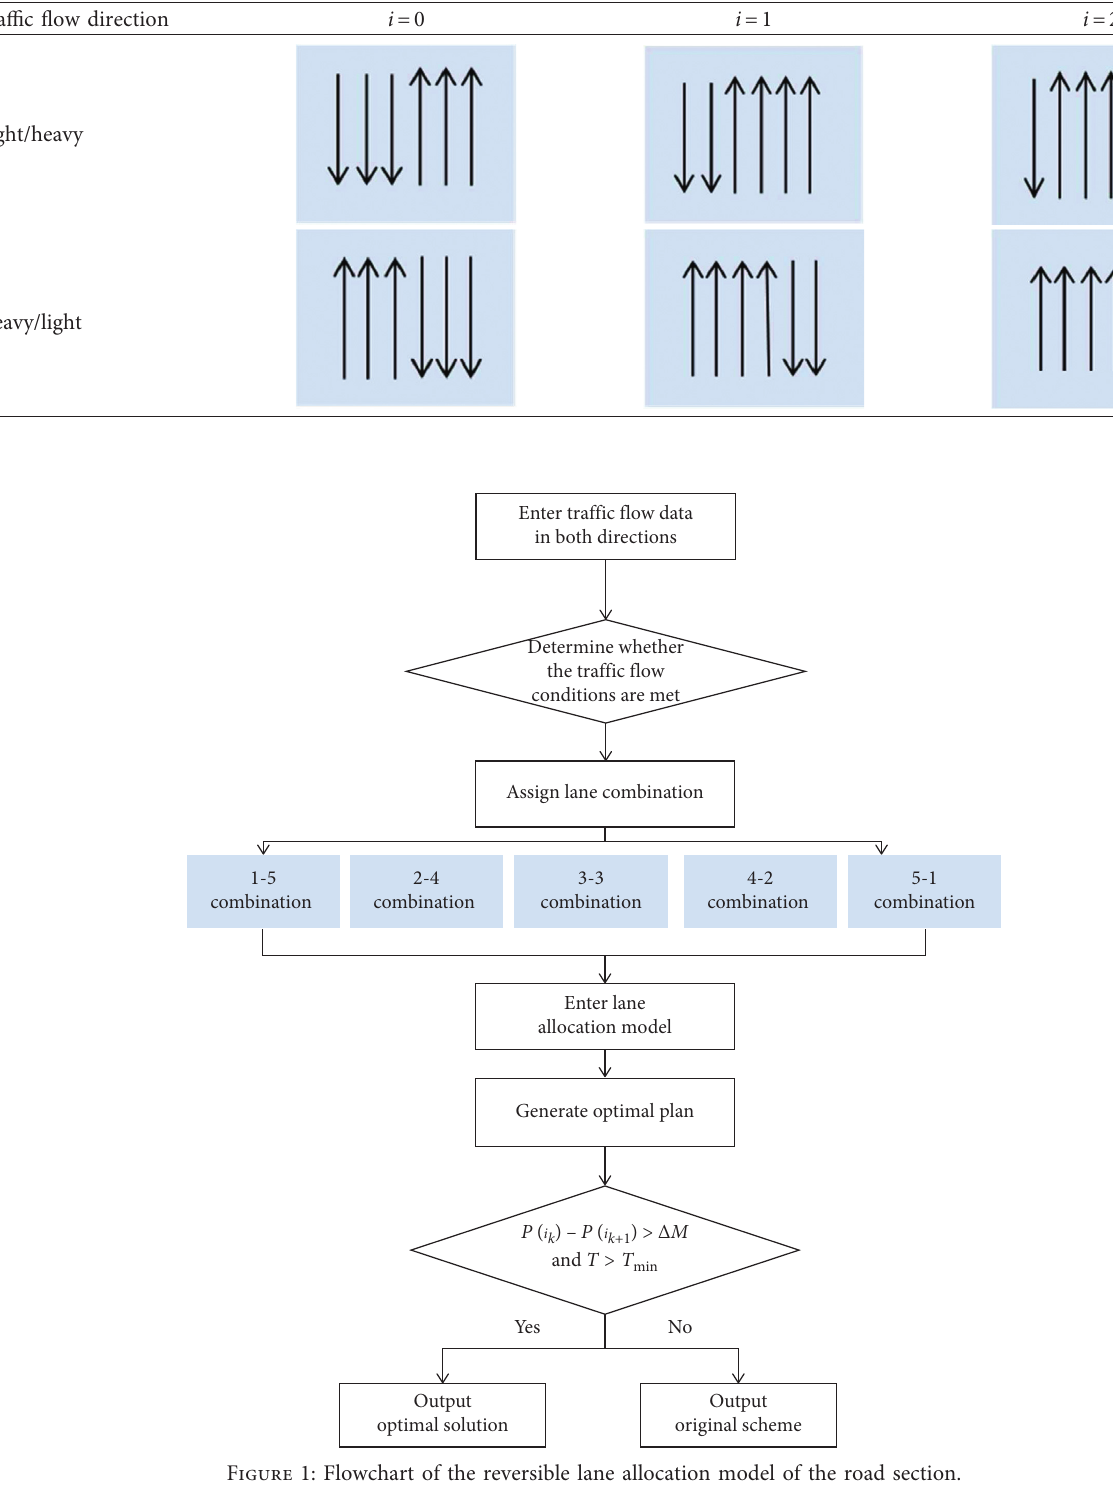
Table 1: Lane combination plans of reversible lanes.